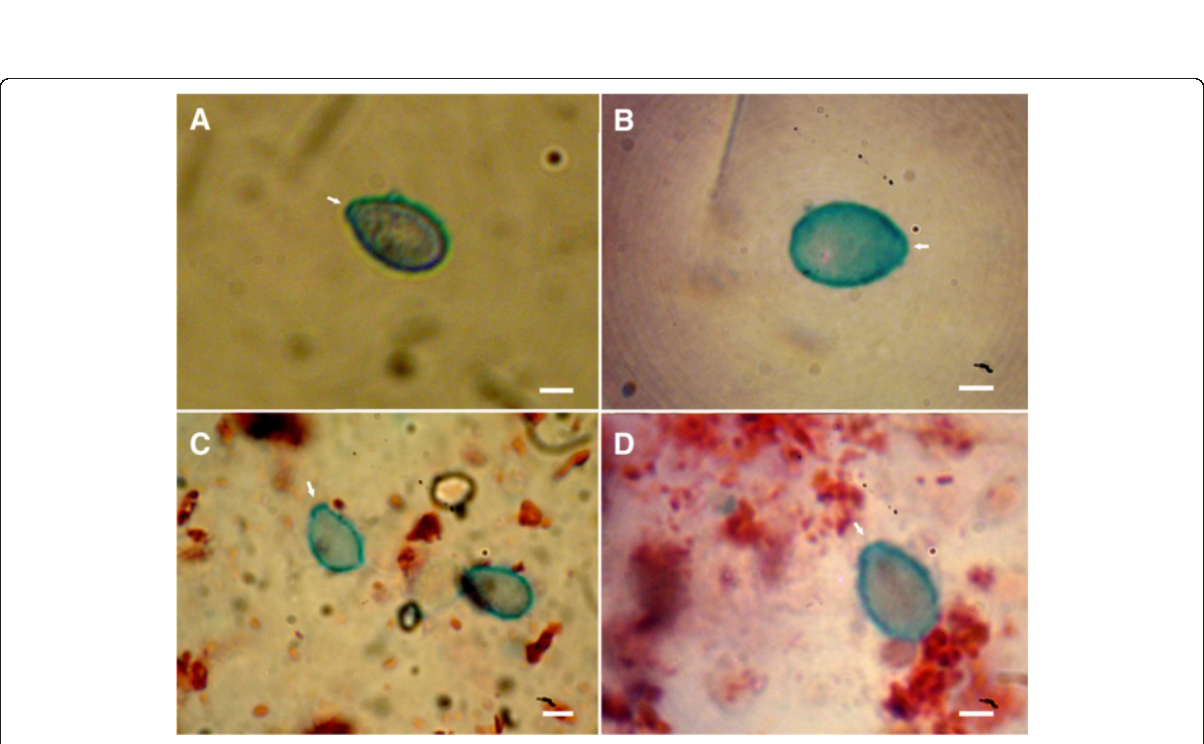
Fig. 5 Nematocytes of C. tagi viewed with alcian blue staining using optical microscopy. Macromolecules with carbohydrate containing carboxyl and/or sulfate groups are stained blue. Arrows are pointing out to operculum. a Isorhiza type. b Outer wall of an undefined nematocyte. c Possible birhopaloids. d Adult eurytele. Bars: ( a and d ) 4 μ m; ( b ) 3 μ m; ( c ) 5 μ